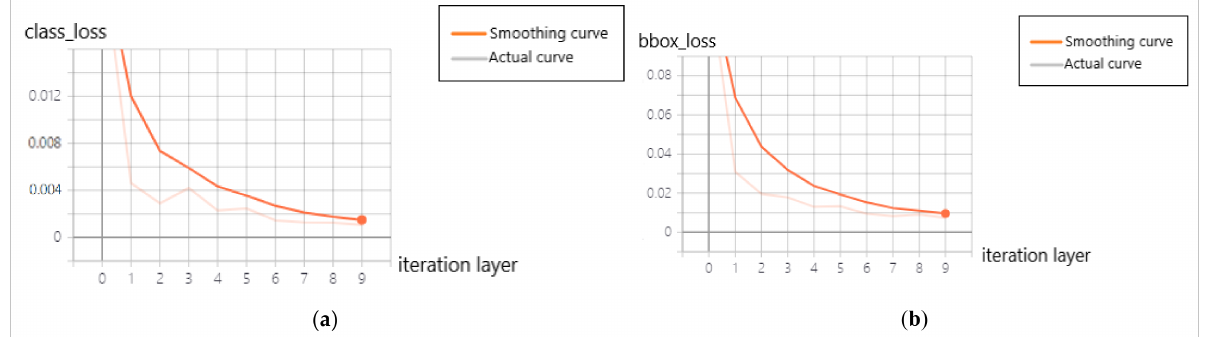
Figure 16. Mask R-CNN loss function 1. ( a ) Class loss ( b ) bbox loss.